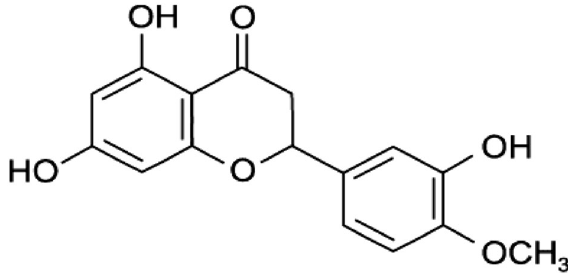
Fig. 15 Structure of hesperetin (3 ′ ,5,7-Trihydroxy-4 ′ -